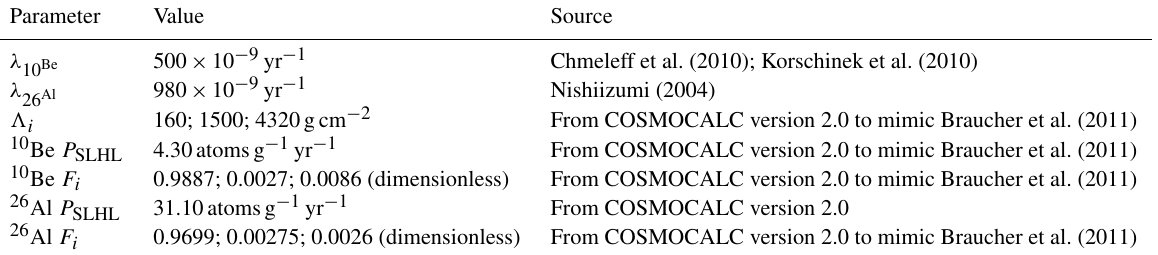
Table 2. Default parameters used in the CAIRN model.